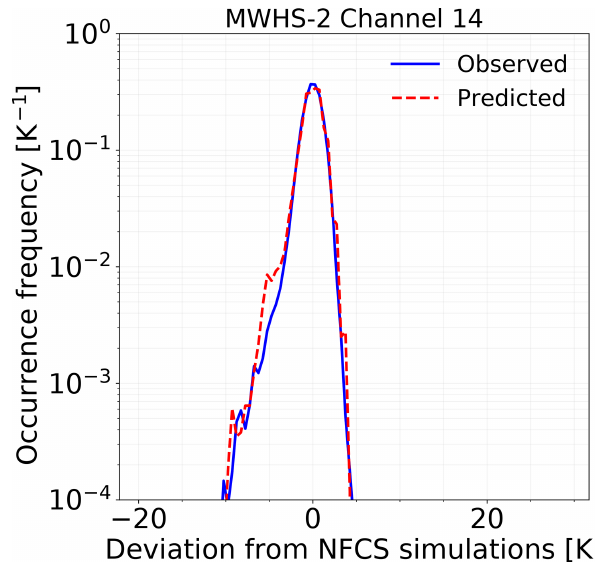
Figure 8. The distribution of predicted errors and observed errors obtained from QRNN-single (89 + 150GHz) for MWHS-2 channel 14. The predicted errors are estimated as deviations of random sam- ples from a posteriori distribution to corresponding median